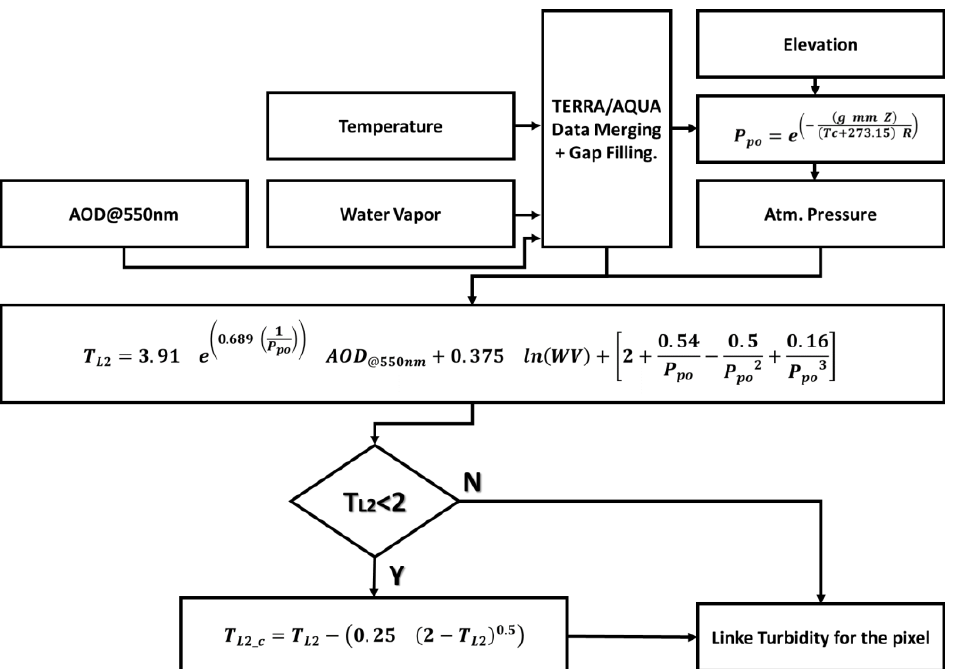
Figure 5. Graphical workflow of Linke turbidity estimation methodology.